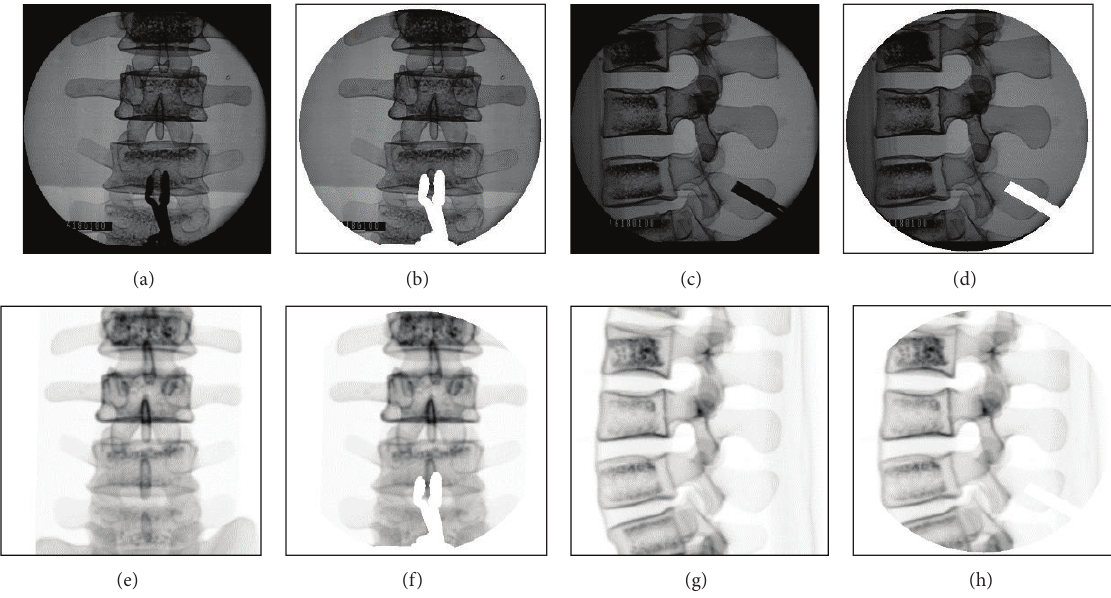
Figure 8: (a) Original AP-view image. (b) Effective AP-view image. (c) Original LA-view image. (d) Effective LA-view image. (e) Original AP-view DRR image. (f) Effective AP-view DRR image. (g) Original LA-view DRR image. (h) Effective LA-view DRR